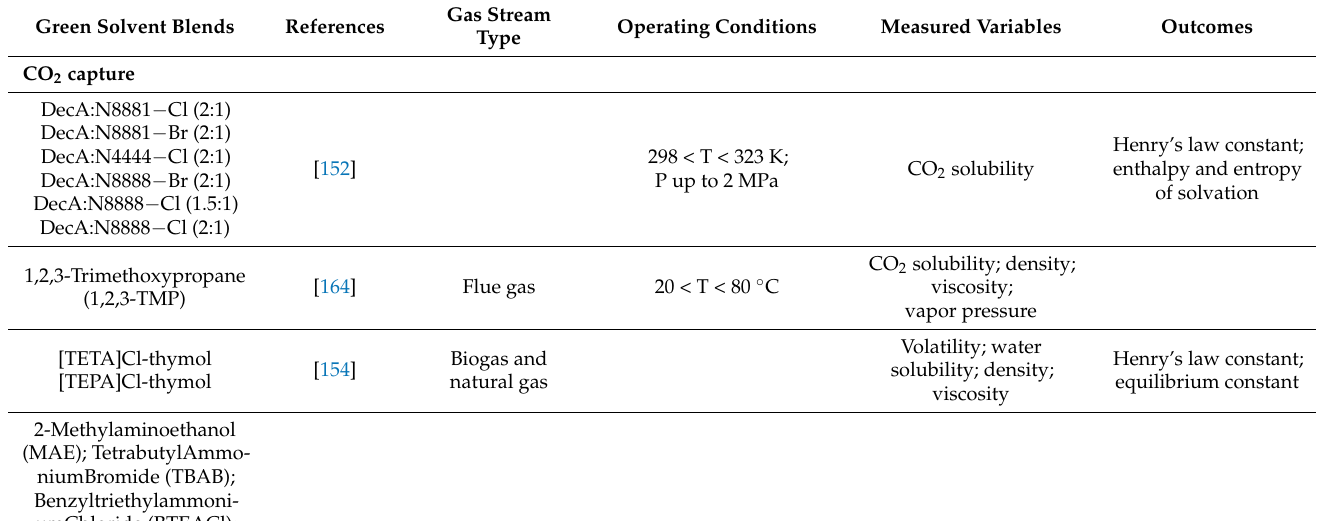
Table 8. Green solvents studied in the literature with relative experimental operating conditions and provided information. Green Solvent